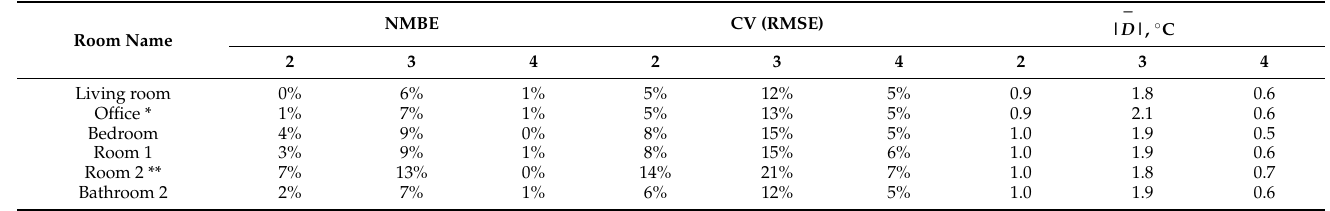
Table 6. Values of normalized mean bias error (NMBE), coefficient of variation of root mean squared error (CV (RMSE)), and average absolute difference ( (monthly